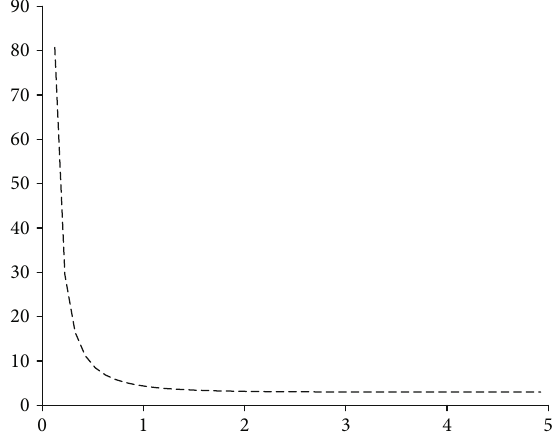
ζ Þ curve in 10 ð